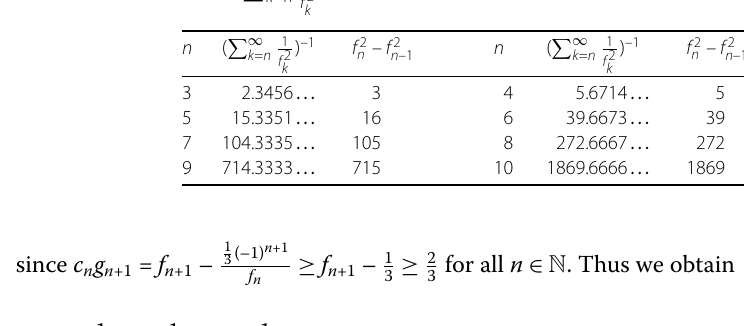
Table 1 Some values of (